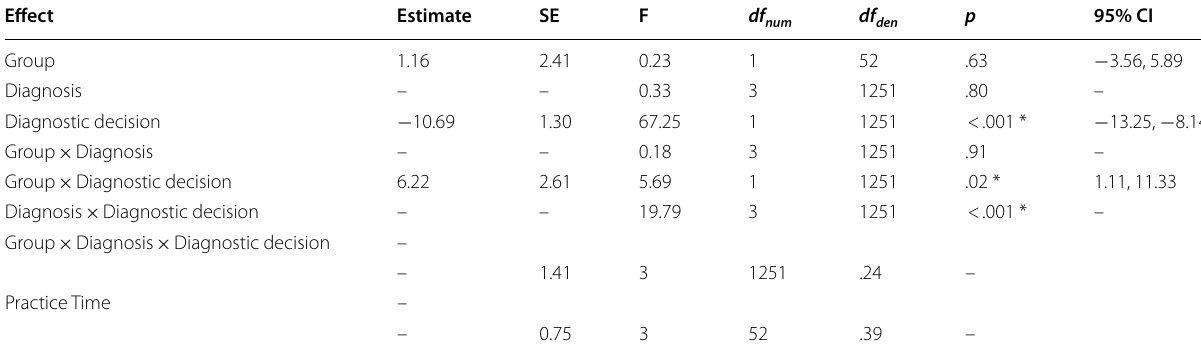
Table 2 Model parameter estimates from Experiment 1